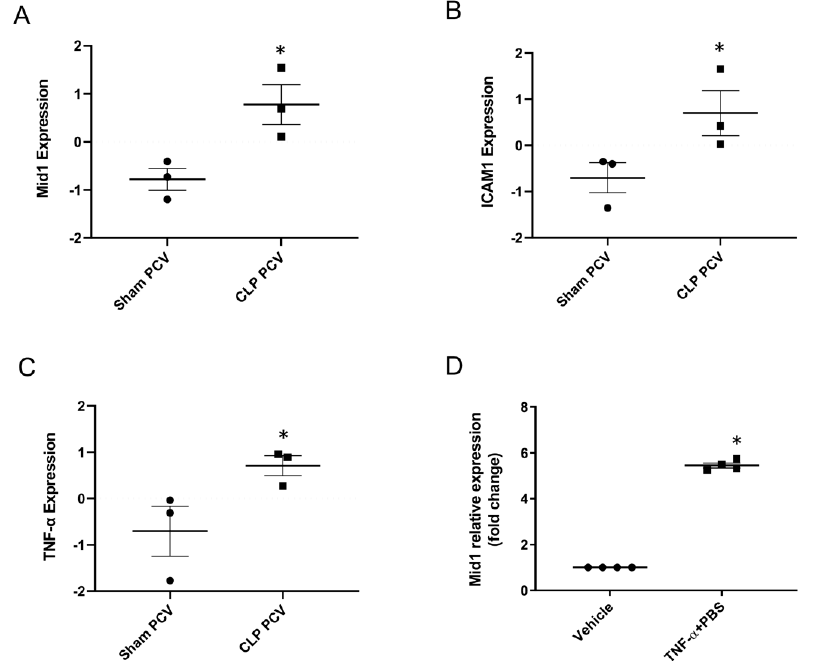
Figure 1. Mid1 expression in endothelial cell lines and lung post-capillary venules of septic mice. ( A ) Mid1, ( B ) ICAM-1, ( C ) TNF- α expression in the lung post-capillary venules. Expression was